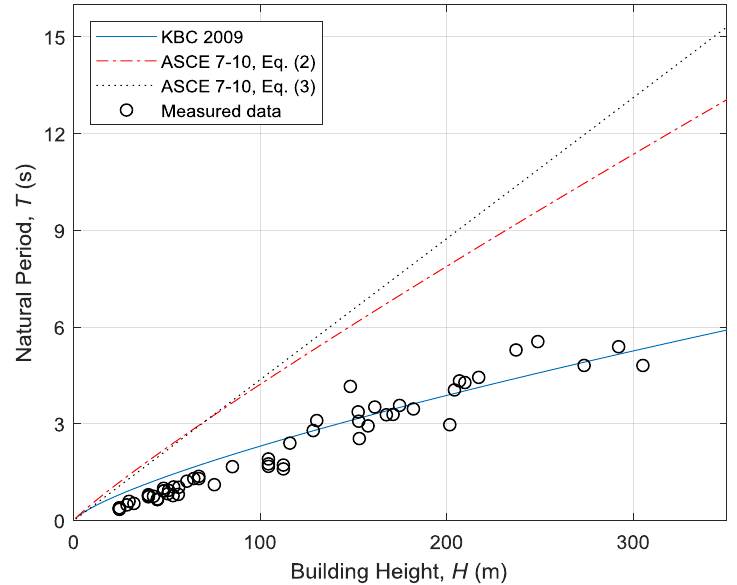
Figure 7. Comparison of KBC 2009 and ASCE 7-10 formulae to measured natural frequency.